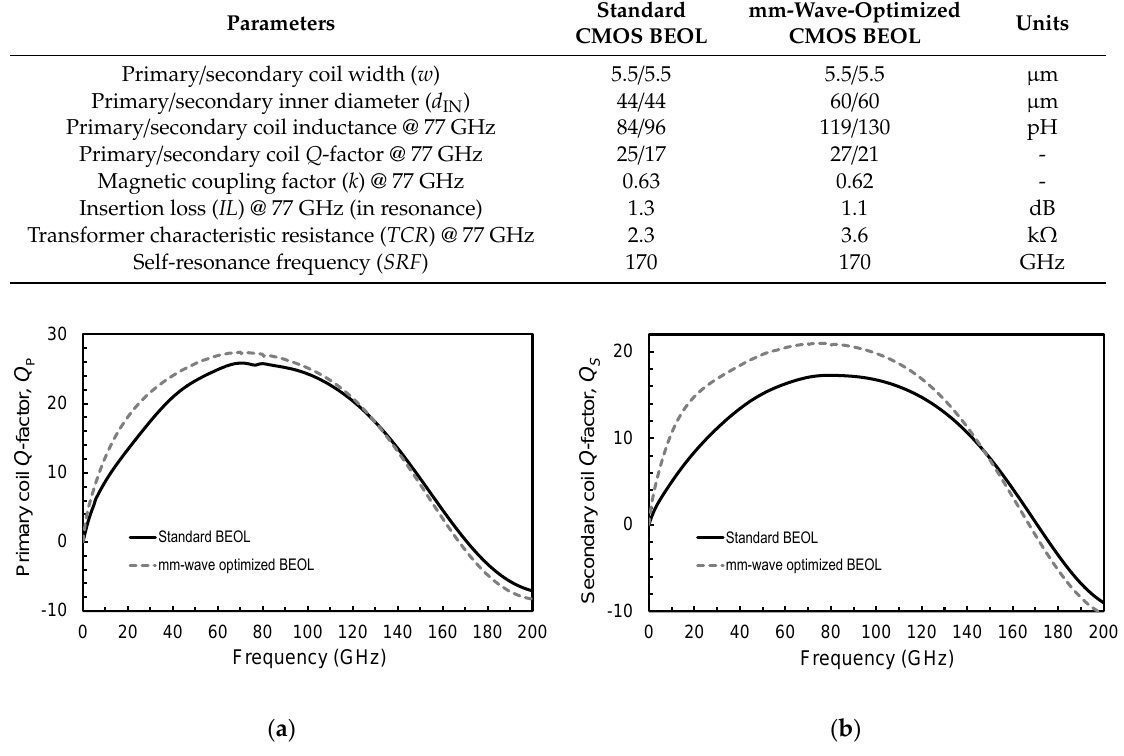
Figure 7. BEOL comparison for stacked transformer T 1 of Table 1. ( a ) primary coil Q -factor, Q P ; ( b ) secondary coil Q -factor, Q S .